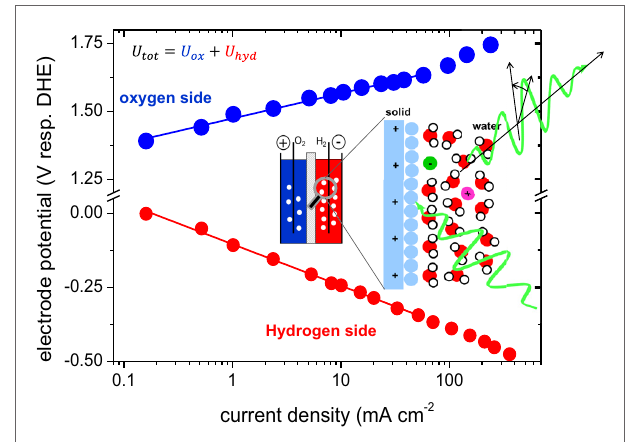
FiGUre 2 | large panel: electrode potentials during alkaline water electrolysis . The required voltage to split water at a given current density is the sum of both potentials, and defines the efficiency of the electrolysis process. The potentials result from the electrochemical (half-) reactions at the electrode– electrolyte interface as sketched in the inset. An analysis of the dynamic process at this interface is an analytical challenge. Novel optical spectroscopy (green lines) may give further insights. Data from Miles et al.